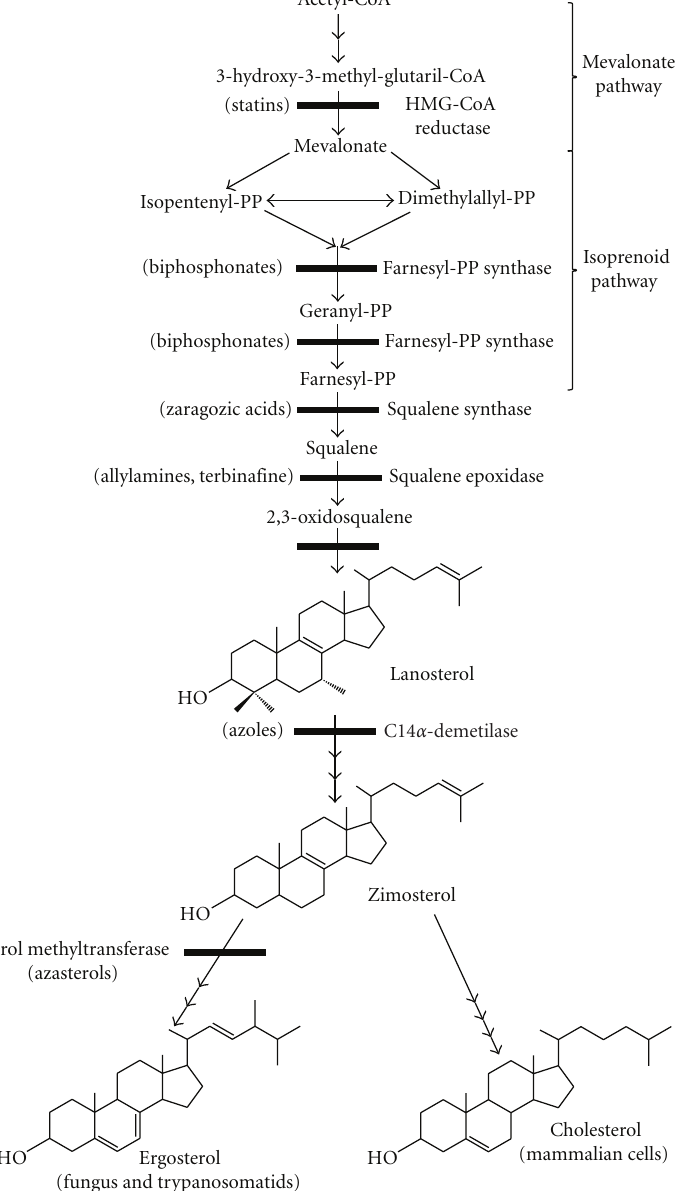
Figure 3: The biosynthesis of ergosterol and cholesterol showing the main steps, the enzymes involved, and the known inhibitors.